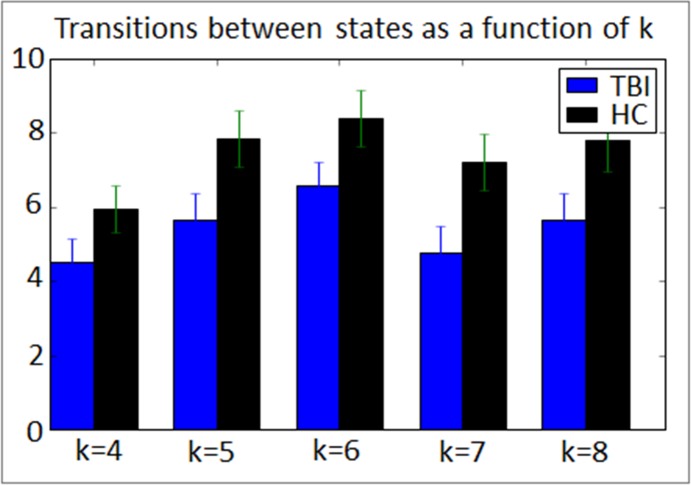
Examining the influence of the number of states (k) on state transitions between groups.The TBI sample reliably shows reduced transitions irrespective of investigator decisions regarding k. Error bars indicate standard error. * = between group difference significant, p<0.1, ** = between group difference significant, p<0.05.